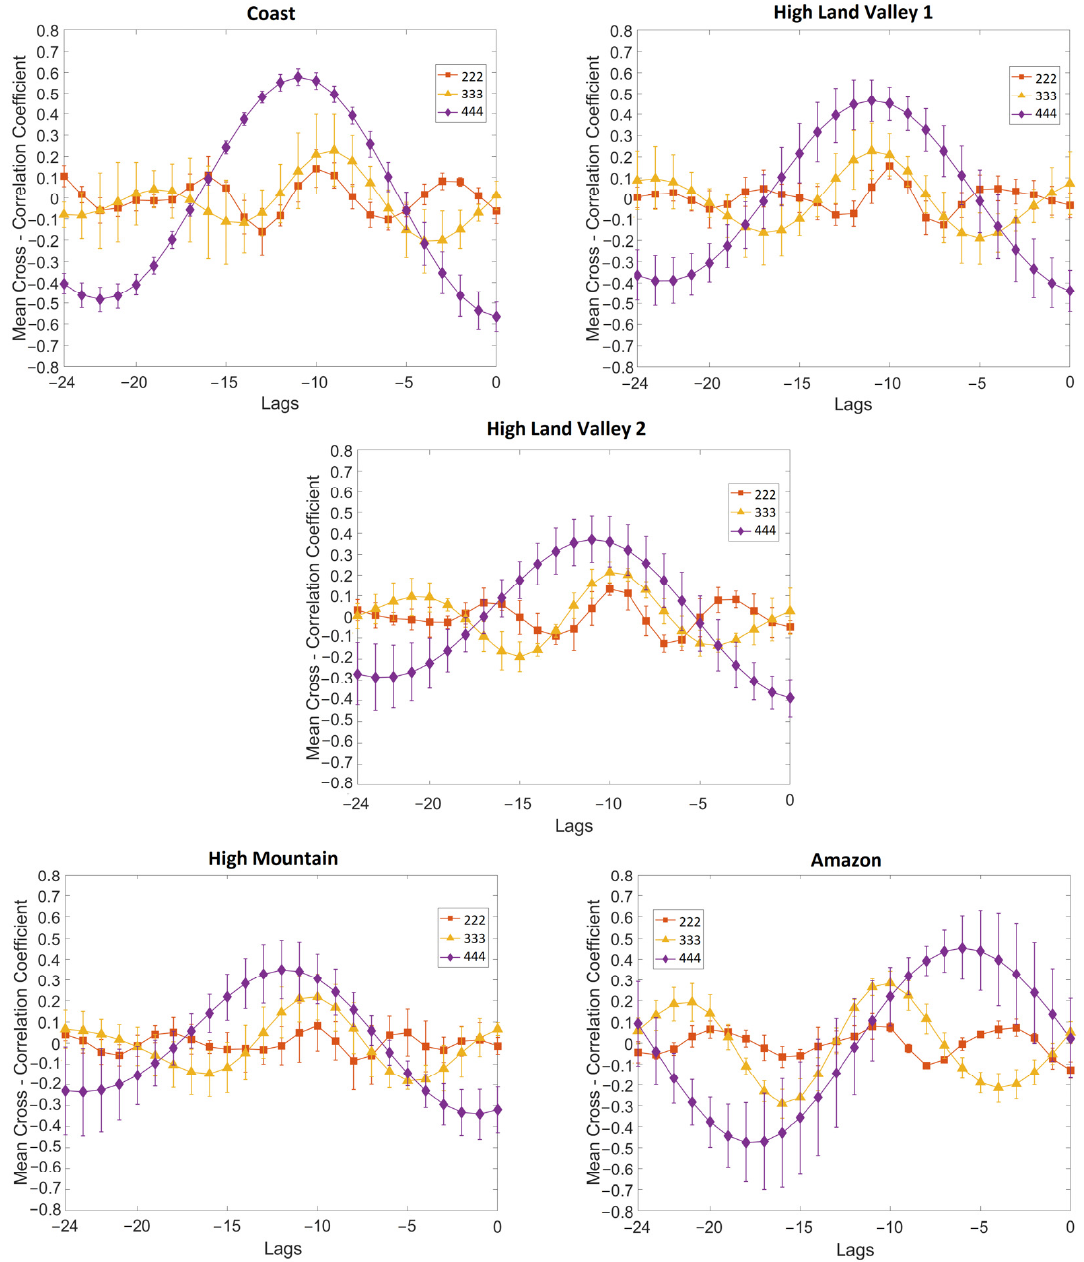
Figure 7. Average of the discrete wavelet correlation lag results registered per level of detail for the selected rainfall events presented in Table 5, including their standard deviation.